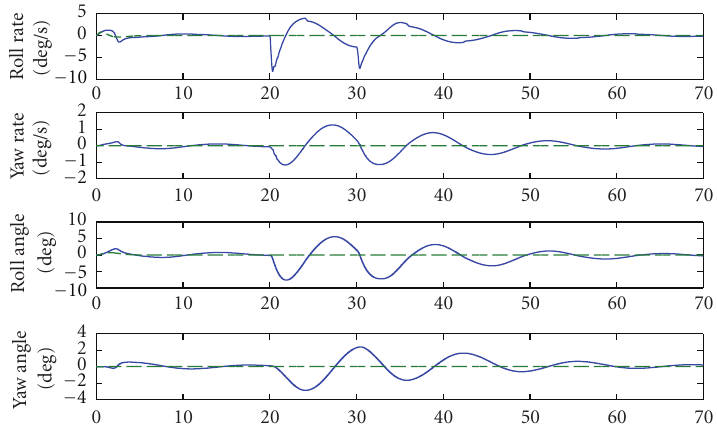
Figure 18: Time history of lateral states (solid) and reference model states